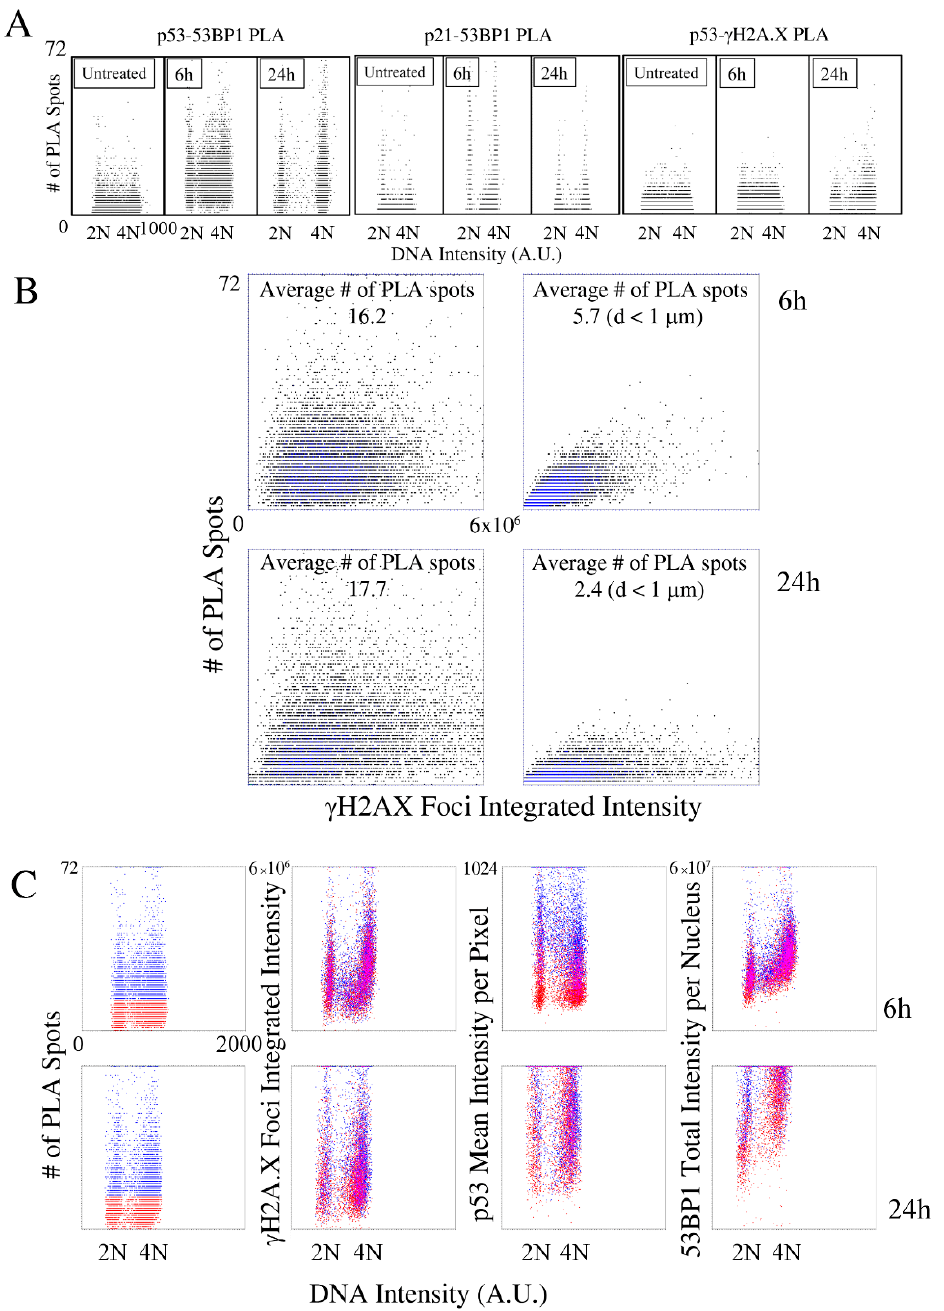
Figure 5. Image cytometry analysis of protein–protein interaction after X-ray irradiation detected by a Proximity Ligation Assay (PLA). ( A ) The dot-plots report the bivariate distribution of DNA content and of the number of interaction spots detected by a PLA assay between the indicated proteins. ( B ) PLA-spot population analysis (independent from the cell of origin) in relation to the position of IR foci. In the dot-plots on the right, only PLA-spots–IR-foci residing within a distance of 1 µ m were considered. ( C ) Analysis of p53-, 53BP1-, and γ H2A.X-related parameters according to the intensity of the 53BP1–p53 interaction. The cell population was subdivided according to the value of the median of the number of PLA spots per cell distribution.